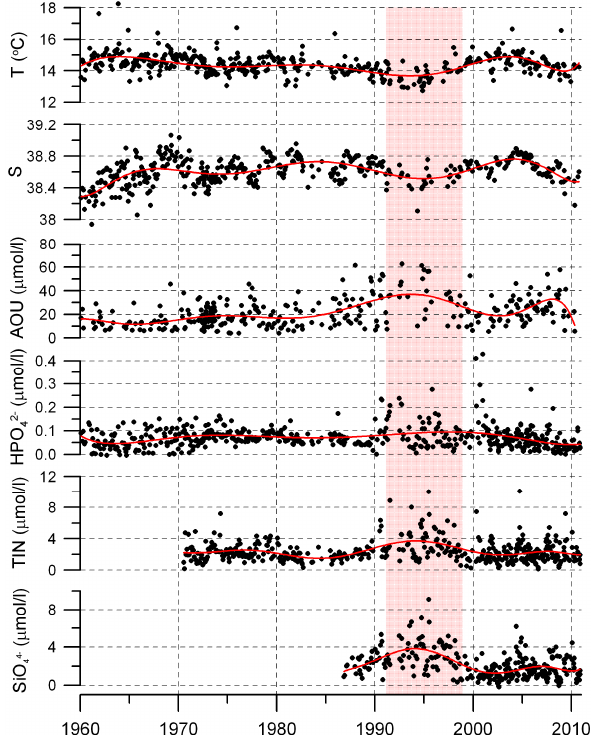
Figure 3. Time series of temperature, salinity, AOU, orthophosphates, TIN, and orthosilicates at the bottom of the station P2 (100 m). Seasonal signal is removed from the series. Full line stands for the polynomial fitting of seventh order, while the 1991-1998 period is marked by shadow.